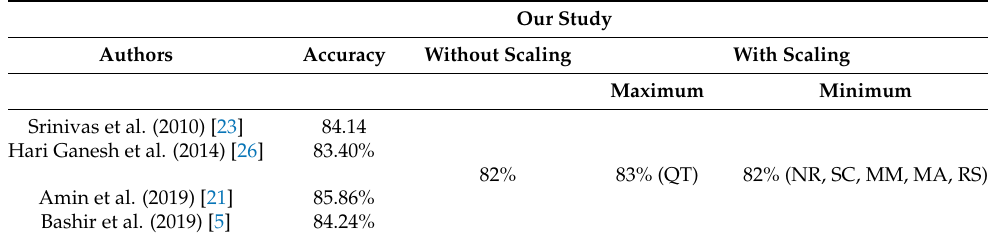
Table 11. Comparison with previous study—NB.